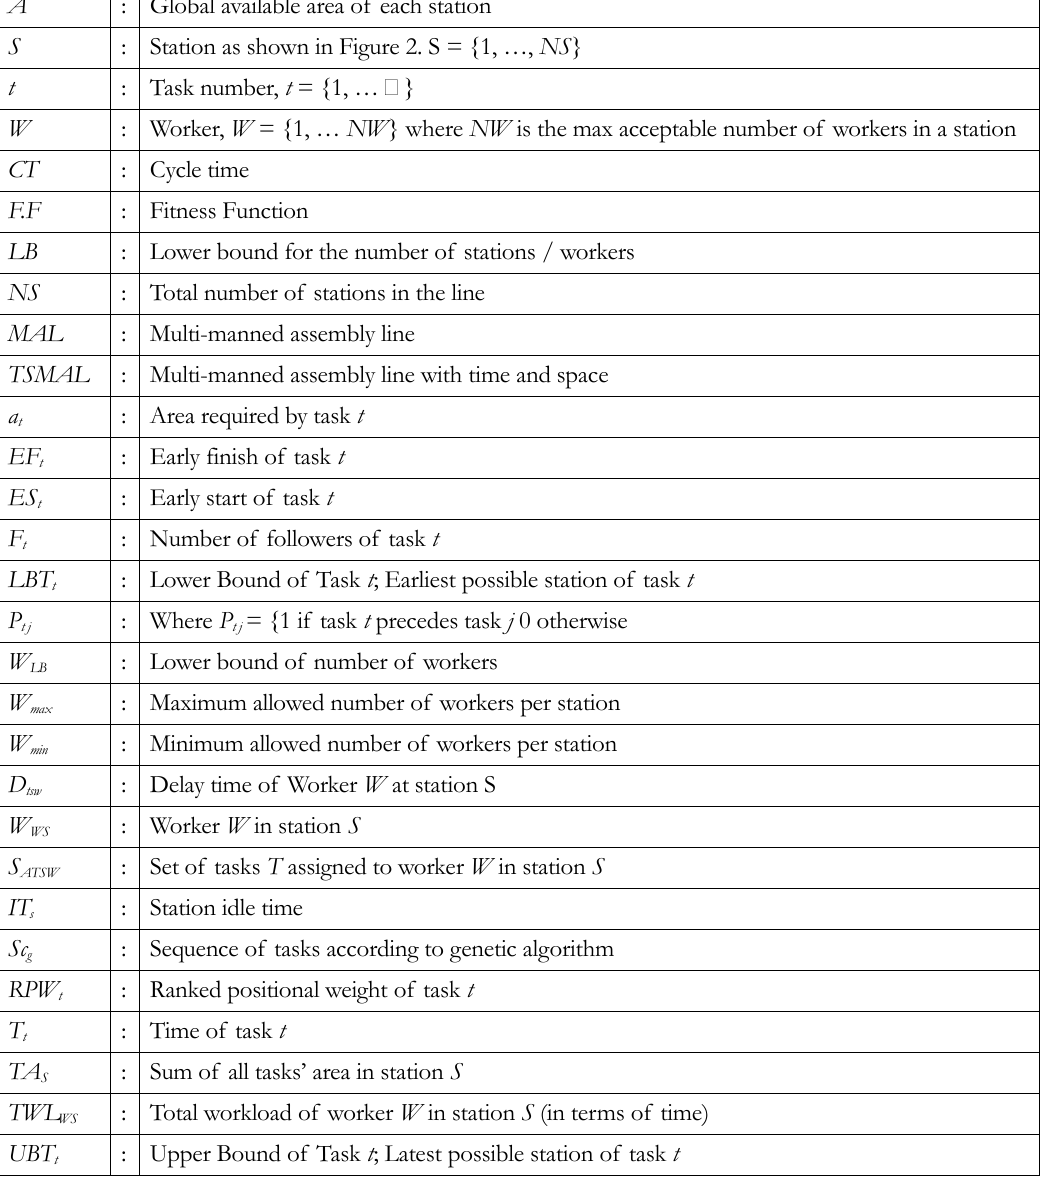
Table 1. Parameter of multi-manned assembly line model with time and space